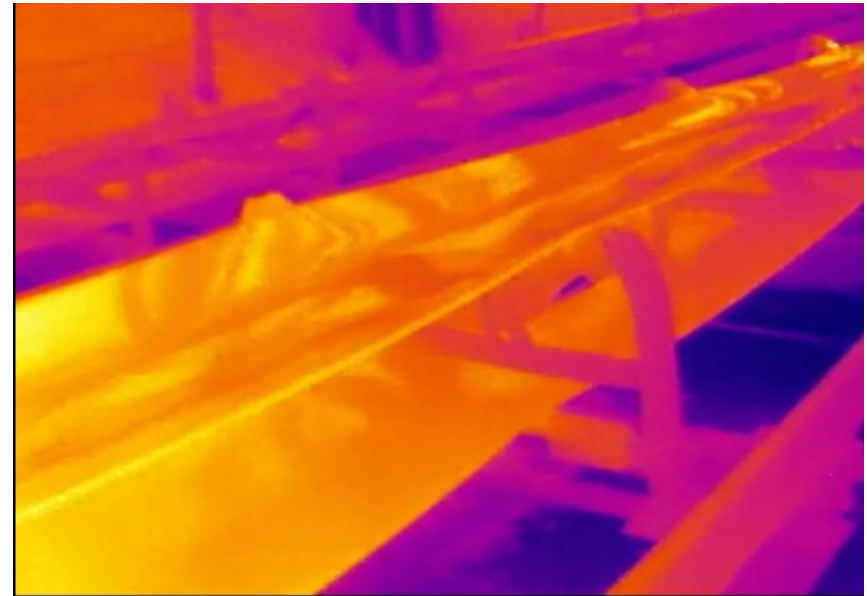
Figure 20. Exemplary frame with problematic case.